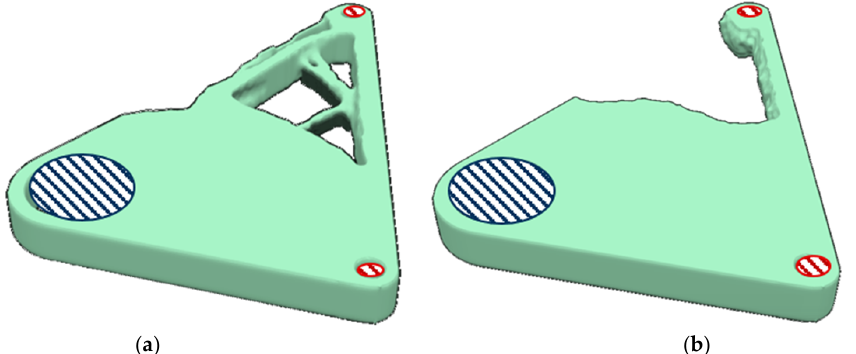
Figure 12. Comparison of the reference design proposal ( a ) and the design proposal with the highest effective material usage ( b ) for the rocker application example. The support-material is displayed in dark green, while constraints are visualized in dark blue and loaded areas in red.